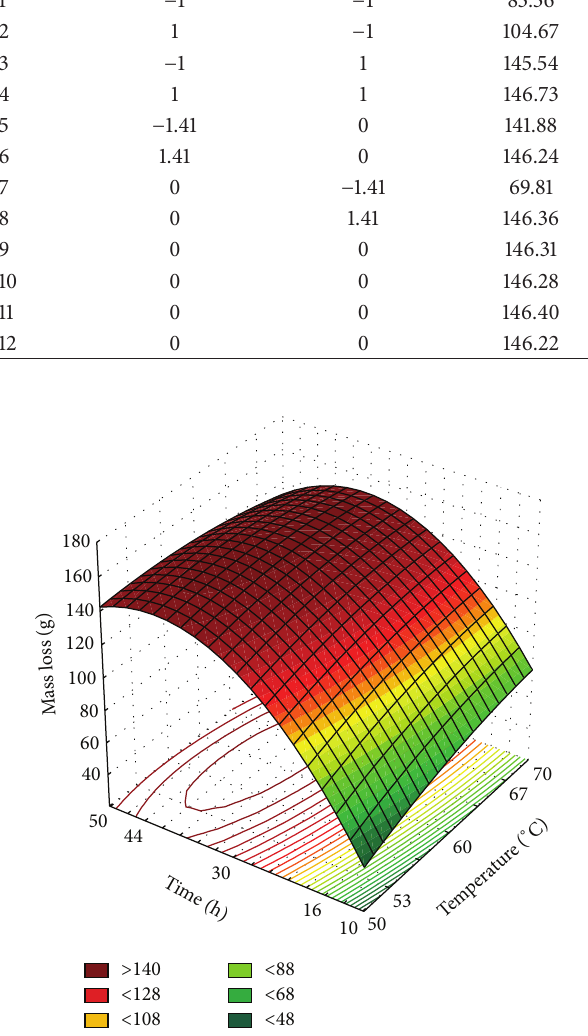
Figure 2: Surface response of tomato dehydration (time × temper-